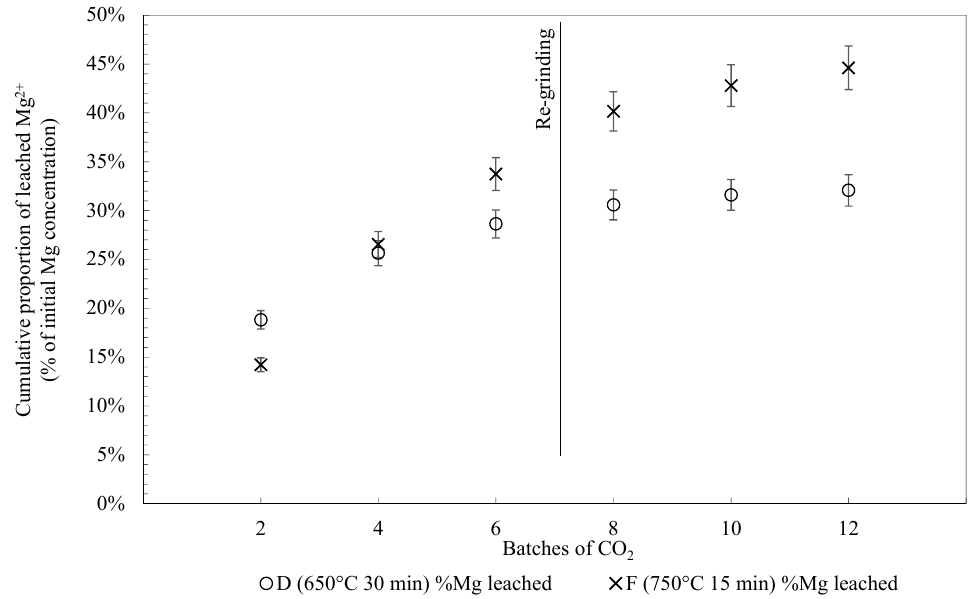
Figure 4. The Mg 2 + leached (expressed in percent of initial Mg 2 + concentration in the solid) for samples Figure 4. The Mg 2+ leached (expressed in percent of initial Mg 2+ concentration in the solid) for samples treated at 650 ◦ C for 30 min (blue) and at 750 ◦ C for 15 min treated at 650 °C for 30 min (blue) and at 750 °C for 15 min (green).